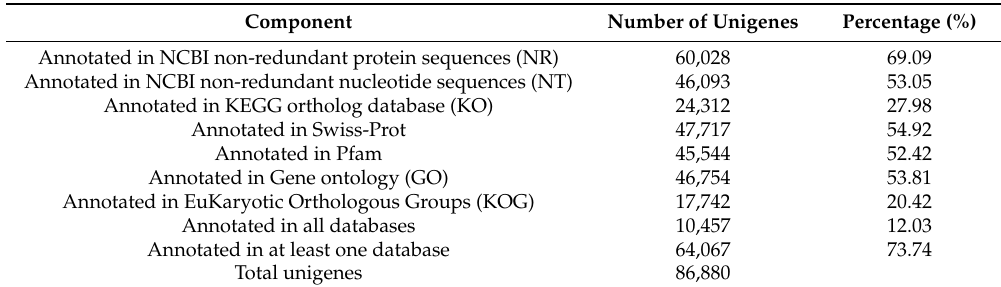
Table 2. Unigenes were annotated to the seven